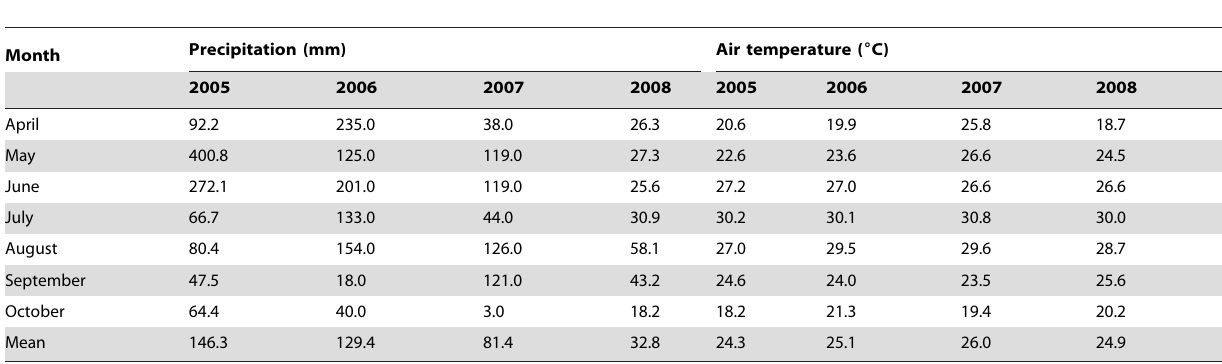
Table 2. Mean monthly precipitation and air temperature from April to October between 2005 and 2008 at the experimental